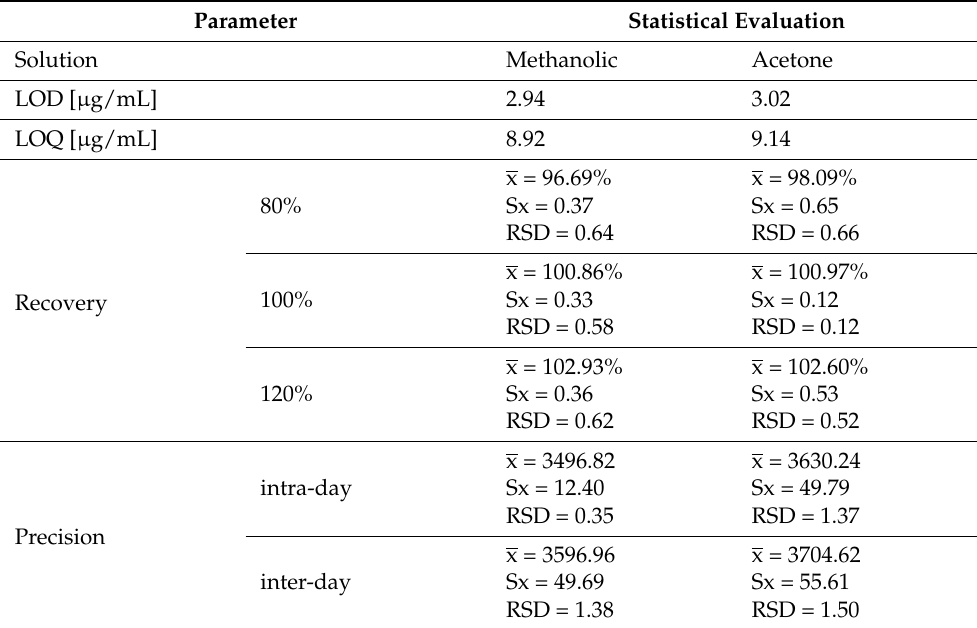
Table 2. Statistical parameters of the LOD, LOD, recovery, and precision of the method.